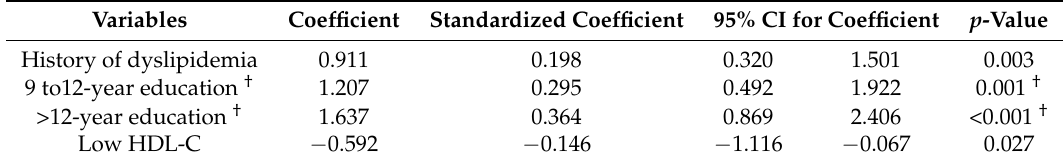
Table 4. Predictors of Metabolic Syndrome Knowledge (n =